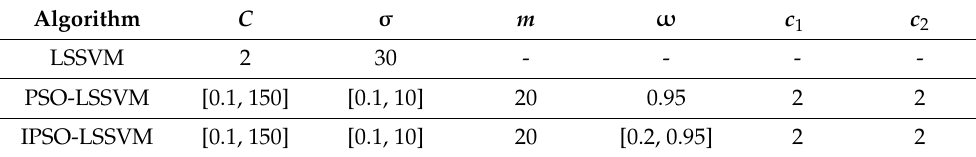
Table 5. Settings of the algorithm parameters.